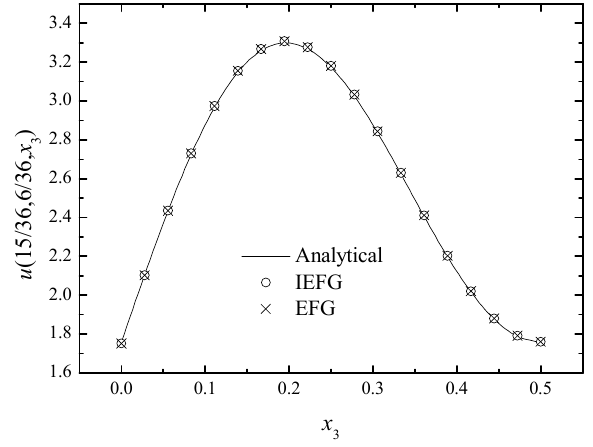
Figure 14. The comparison of numerical and exact solutions along x 3 -axis.